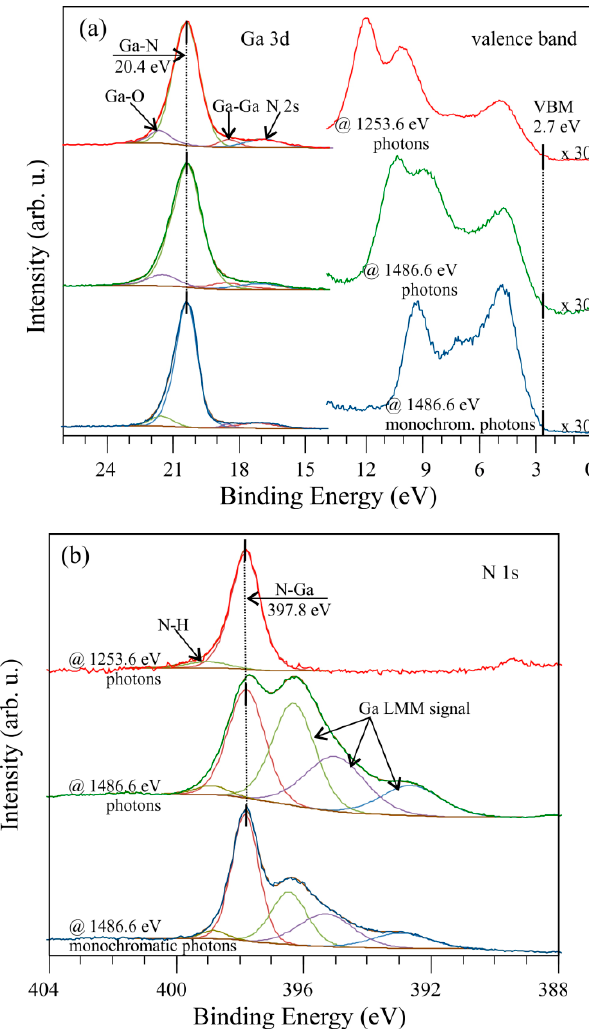
Figure 3. X-ray photoelectron spectroscopy (XPS) spectra of ( a ) Ga-3d and the valence band as well as ( b ) the N 1s for a nondoped GaN(0001) surface, collected with different photon sources.